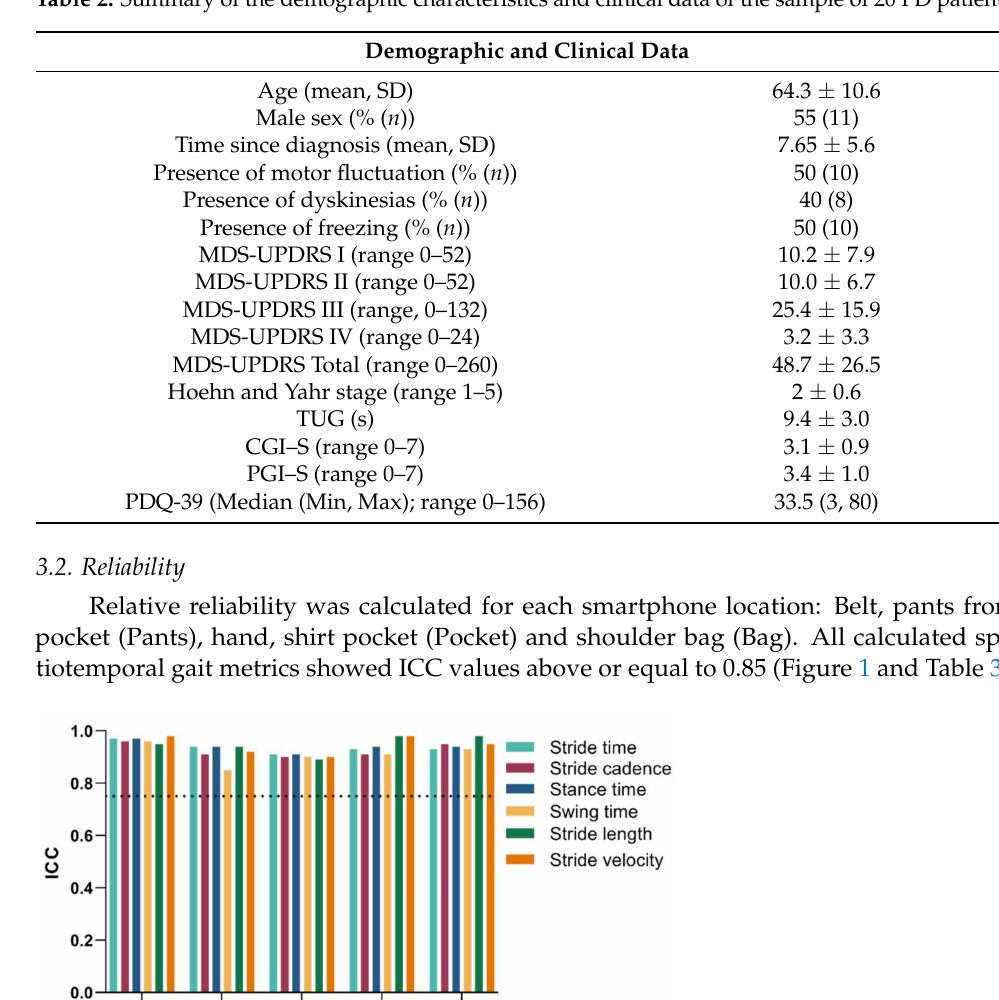
Table 2. Summary of the demographic characteristics and clinical data of the sample of 20 PD patients.